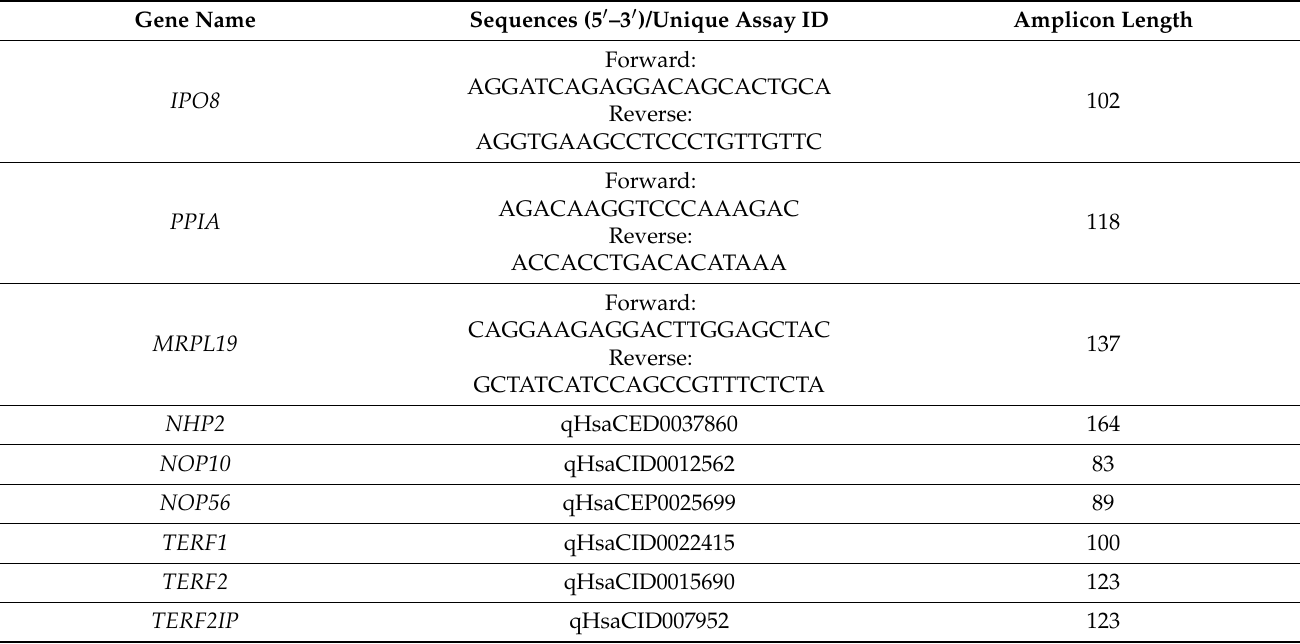
Table 5. Gene Sequences and amplicon length of all genes examined, IPO8, PPIA, MRPL19, NOP10, NHP2, NOP56, TERF1, TERF2 and TERF2IP